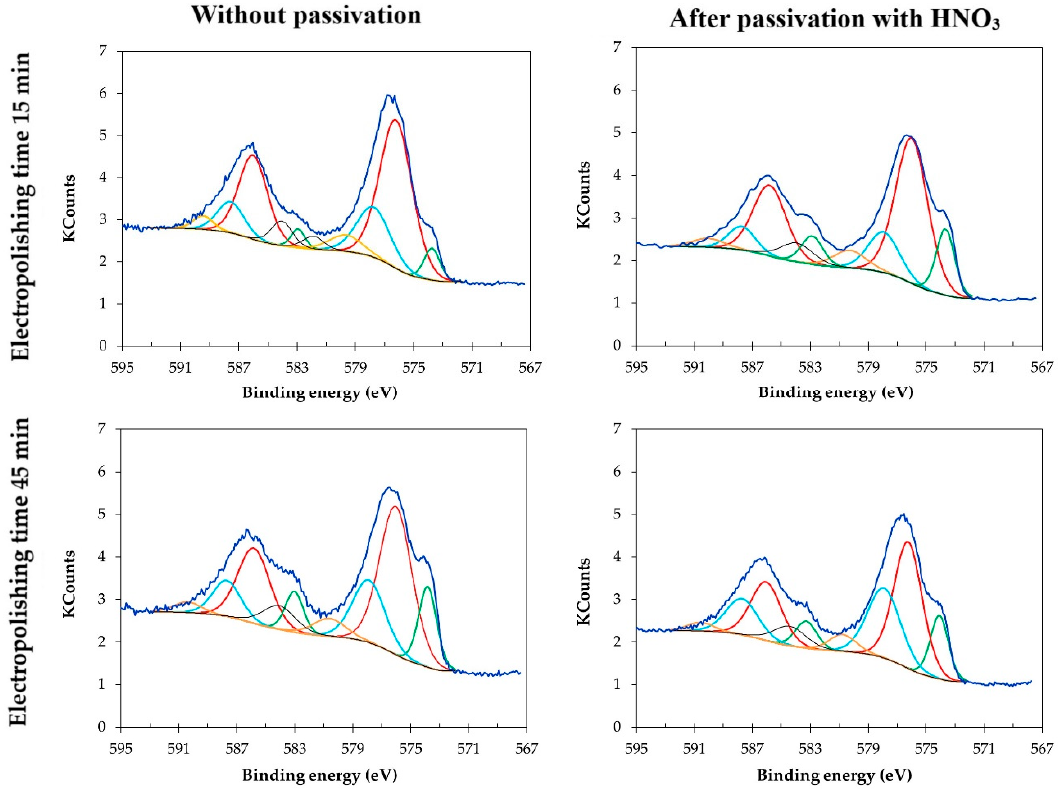
Figure 8. Cr2p deconvolutions for chromium-nickel steel surface samples electropolished in laboratory scale S1-LAB.